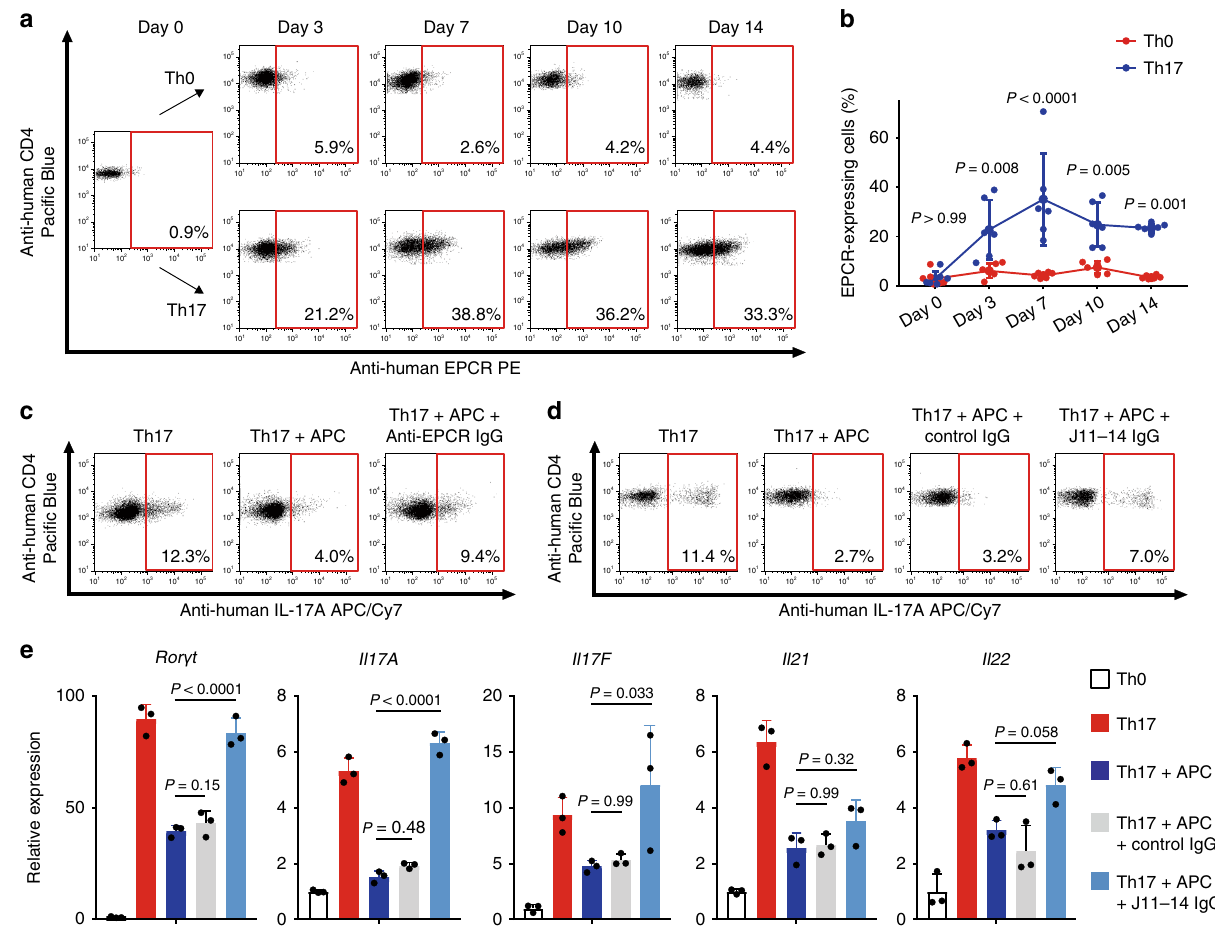
Fig. 6 Anti-EPCR autoantibodies in Takayasu arteritis negatively regulates Th17 differentiation. a , b Human naive CD4 + T cells were cultured under Th0 (anti-CD3/anti-CD28 stimulation alone) or Th17 conditions (anti-CD3/anti-CD28 stimulation followed by the addition of interleukin [IL]-6, IL-1 β , IL- 23, TGF- β 1, anti-human interferon- γ antibody, and anti-human IL-4 antibody). The proportion of cells expressing EPCR on day 0, 3, 7, 10, or 14 was analyzed with fl ow cytometry. Representative dot plots ( a ) and the summary graph ( b n = 3) are shown. c , d Human naive CD4 + T cells were stimulated and cultured under Th17 differentiation conditions, and production of IL-17A on Day 7 was analyzed with fl ow cytometry. Cells were cultured with or without 10 µ g/mL APC and incubated with isotype or anti-EPCR antibody ( c ). Cells were cultured with or without 10 µ g/mL APC, and control IgG or IgG from an anti-EPCR-positive TAK AECA sample (J11-14) was further added ( d ). e Human naive CD4 + T cells were cultured under Th17 conditions with or without IgG and with or without 10 µ g/mL APC for 7 days. IgG included 2.56 mg/mL control IgG and 2.56 mg/mL IgG from anti-EPCR positive TAK AECA (J11-14). The relative expression of Ror γ t , IL-17A , IL-17F , IL-21 , and IL-22 mRNA were measured with quantitative PCR ( n = 3). GAPDH was used as internal control. Data are indicated as mean ± SD. At least three independent experiments were performed in all cases. Statistical analysis was performed using two-way ANOVA test ( b ) or one-way ANOVA ( e ) followed by Tukey ’ s post hoc test. J11-14 indicates the serum sample